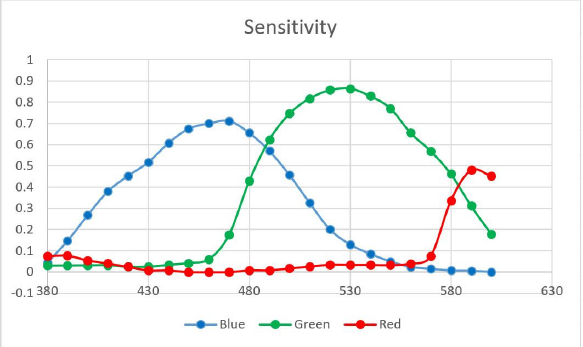
Figure 2. DigiCAM 100 RGB: System performance for red, green, and blue channel over different wavelengths [nm]